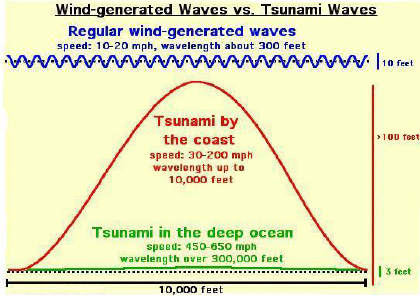
Figure 2 The picture illustrating the occurrence of tsunami due to tectonic earthquakes Tsunamis are unlike wind-generated waves. The wind-generated waves might have a period of about 10 seconds and a wave length of 150 m. A tsunami, on the other hand, can have a wavelength in excess of 100 km and period on the order of one hour.